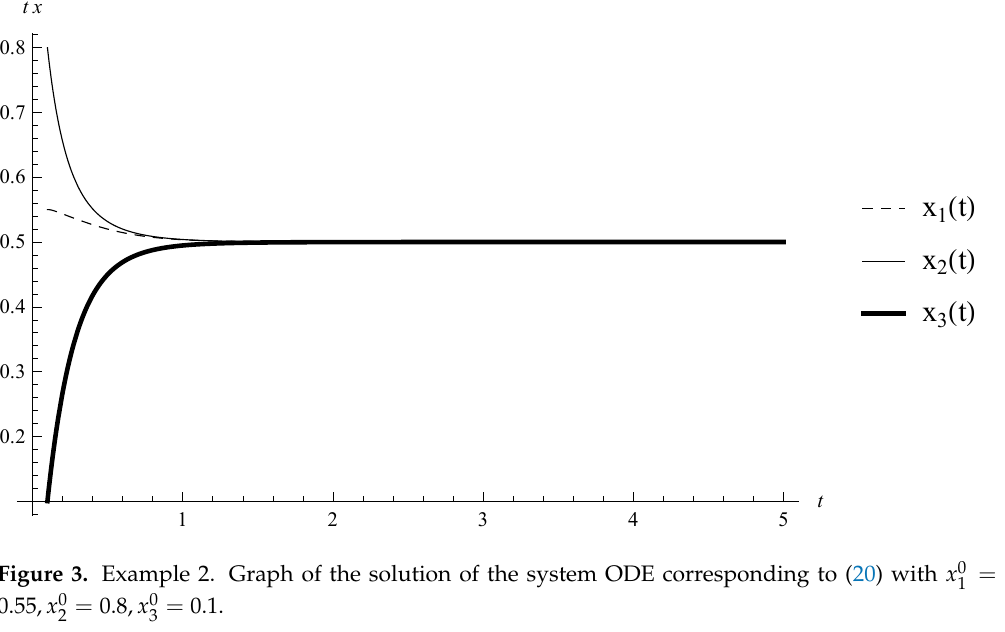
Figure 3. Example 2. Graph of the solution of the system ODE corresponding to (20) with x 0 = 0.8, x 0 = 0.1. 0.55, x 0 2 3